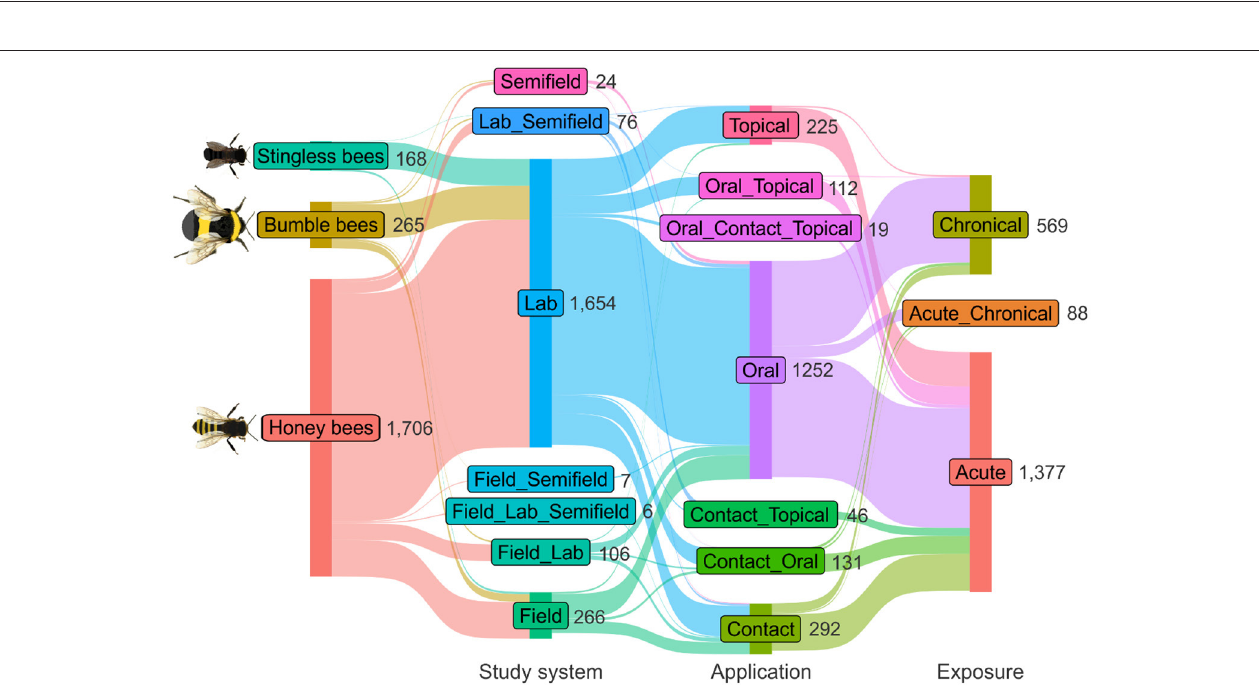
FIGURE 4 | Interaction flows among the study systems, applications, and exposures that were assessed in the main groups of bees found in the literature review ( n = 2,139) on toxicological assessment of agrochemicals for insect pollinators. The values on the right side of each node indicate the number of trials. The thickness of the nodes (rectangles) and arcs (links going from one node to another) is proportional to the frequency of interactions. Terms separated by dash indicate that both terms were assessed.